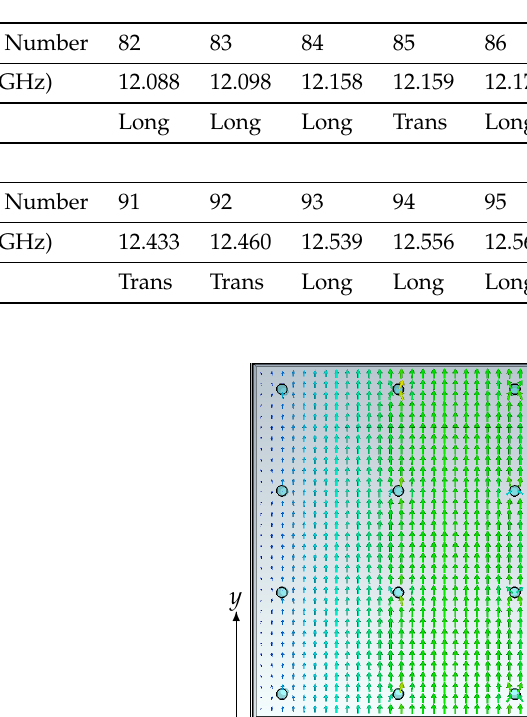
Table 1. Modes of the modulated wire media in a cavity that are nearby to our chosen longitudinal mode (index 90, shown in bold) . They are categorized into either transverse (‘Trans’) or longitudinal modes (‘Long’). This depends on the field patern of the electric field. The electric field in the longitudinal modes is principally parallel to the wires as in Figure 8 whereas in the transverse modes it is perpendicular to the wires, Figure 14.